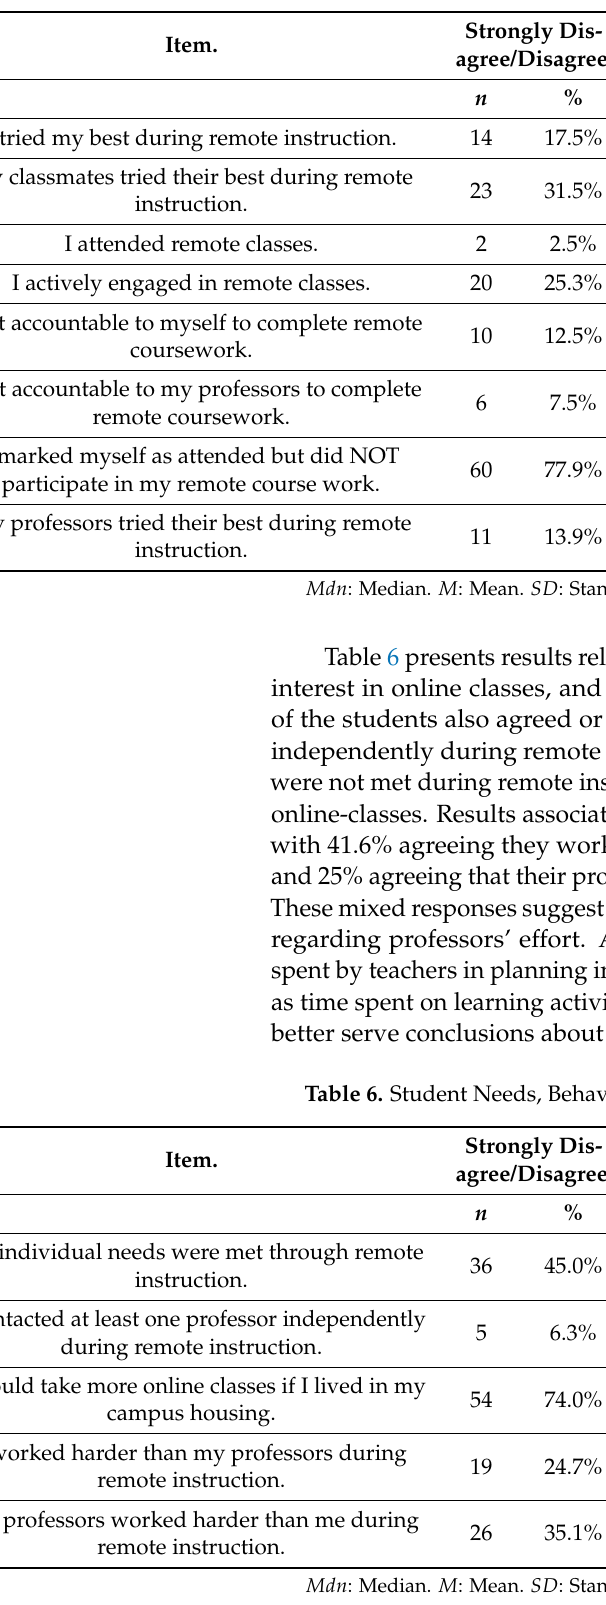
Table 5. Student Effort and Engagement.